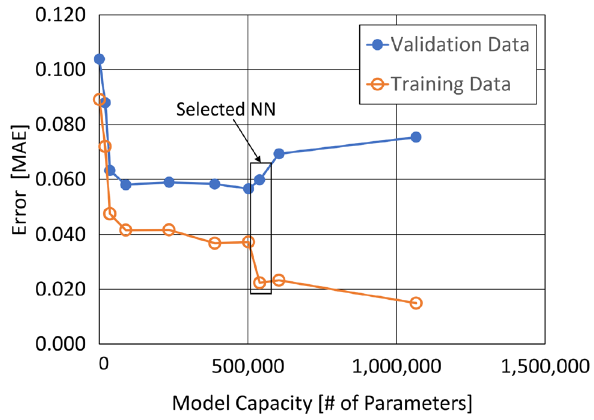
Figure 4. Error vs model capacity of 1DCNNs with manually selected hyperparameters, without